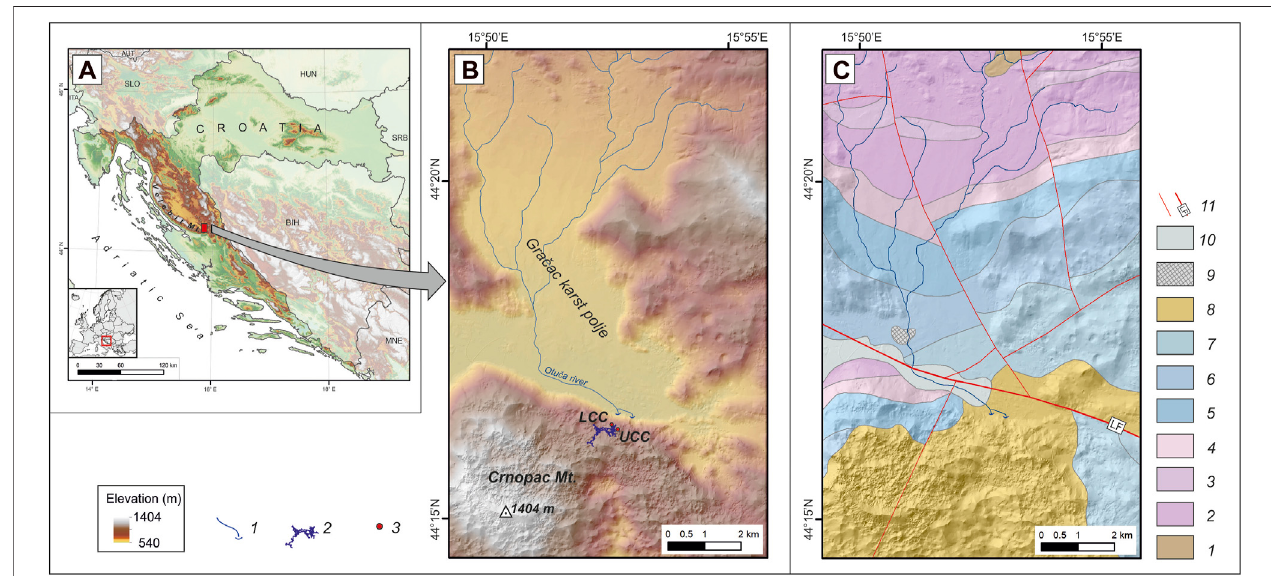
FIGURE1|(A) GeographicpositionoftheCerova ˇ ckeCaves, (B) Elevationmapofthesurroundingarea,legend:1 — surfacestreamswithponors,2 — cavechanells of Lower and Upper Cerova ˇ cka Cave, 3 — entrance positions of Lower (LCC) and Upper (UCC) Cerova ˇ cka Cave, (C) Geological map of the surrounding area, sources: Geological map of Croatia 1:300.000 (Croatian Geological Survey, 2009), Basic geological map of Croatia 1:100.000, sheet Obrovac (Ivanovi´c et al., 1973), Basic geologicalmapofCroatia1:100.000,sheetUdbina( ˇ Su ˇ snjaretal.,1973),legend:1 — clasticrocks(C,P),2 — carbonaterocks(T 2 ),3 — clastic-pyroclasticrocks(T 3 ), 4 — dolomites(T 3 ),5 — limestonesanddolomites(J 1 ),6 — thicklayeredlimestonesanddolomites(J 2 ),7 — limestonesanddolomites(J 3 ),8 — carbonate(Jelar)breccia(Pg, Ng), 9 — alluvial deposits (Q), 10 — Terra Rossa (Q), 11 — faults, LF — Lika fault.